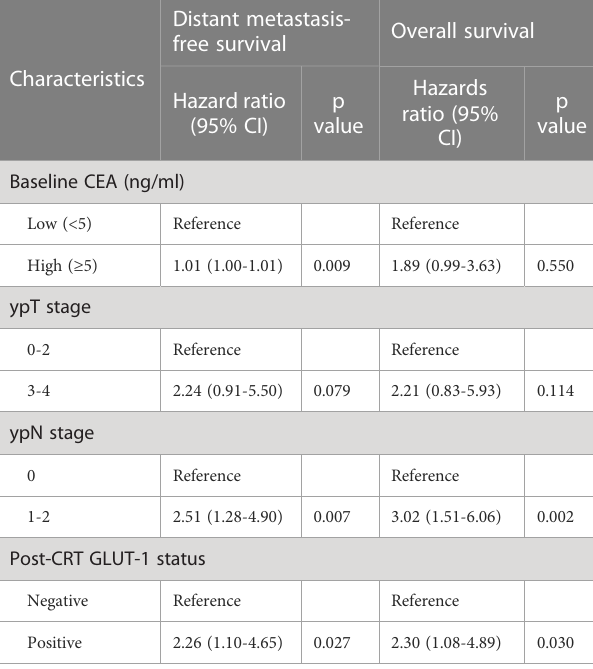
Characteristics